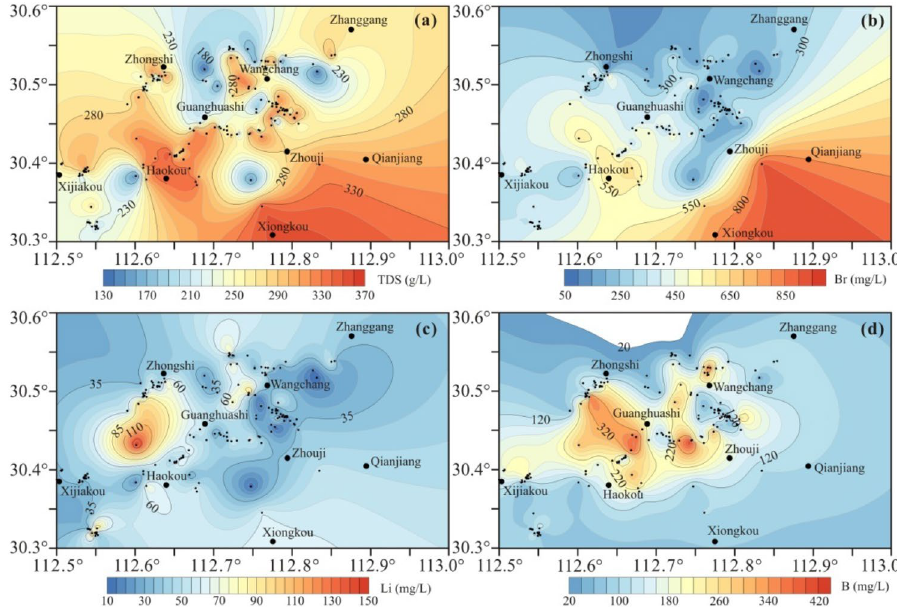
Figure 7. Contour diagrams of Li, B and Br concentrations and salinity of oilfield brines in the Qianjiang Depression. The area is shown in Fig.